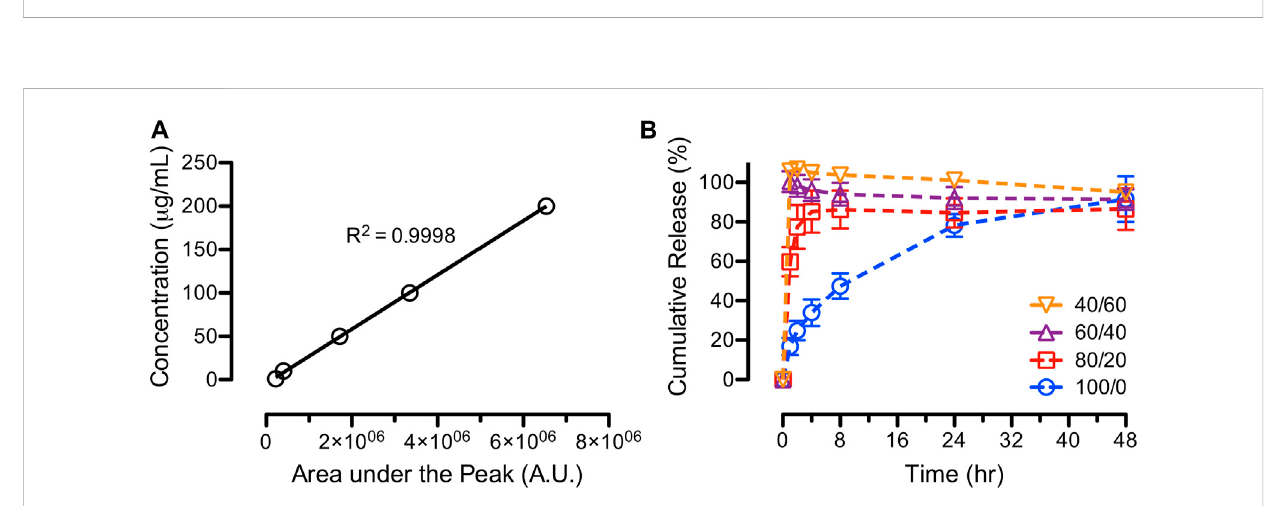
FIGURE 7 In-vitro release studies of ASA from PCL/CS blend fi bers, showing (A) standard curve of known concentrations and (B) cumulative releases of ASA over 48 h for various PCL/CS blend fi bers.